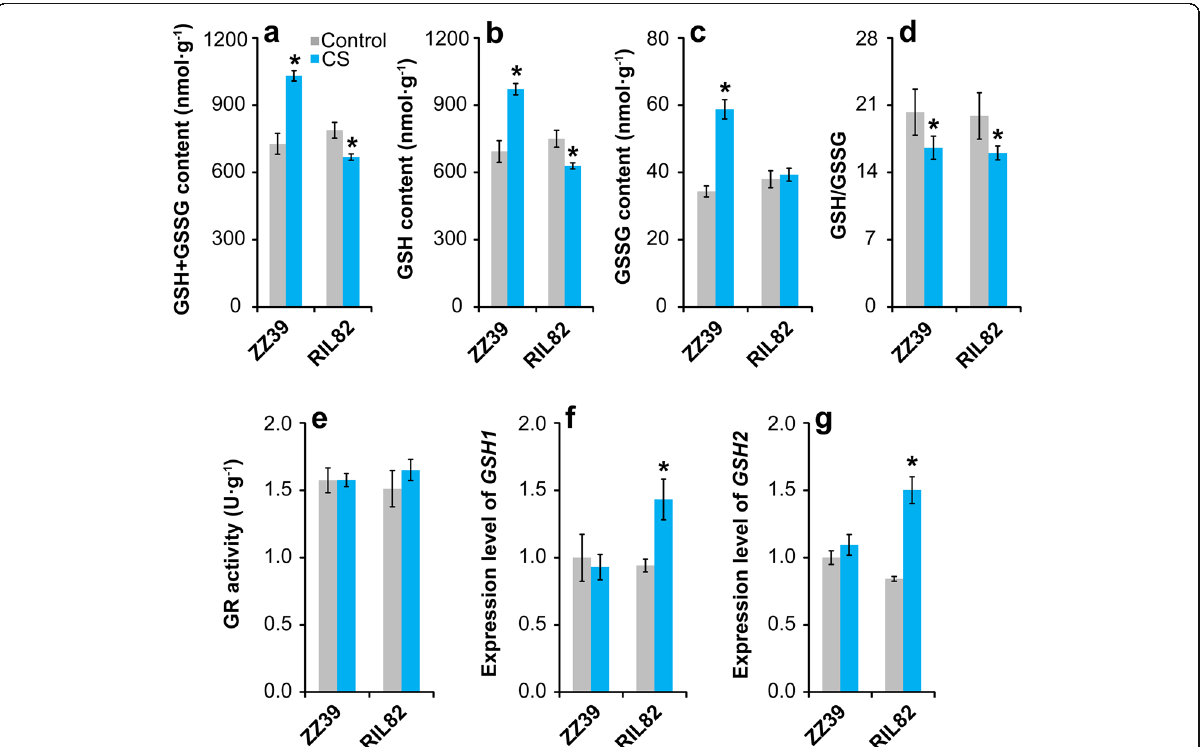
Fig. 3 Effect of cold stress on the GSH metabolism in rice leaves. a , GSH + GSSG; b , GSH; c , GSSG; d , GSSG/GSH; e , GR activity; f , GSH1 ; g , GSH2 . GSH, glutathione; GSSG, glutathione disulphide (Oxidant glutathione); GR, glutathione reductase. Vertical bars denote standard deviations ( n = 4). A t-test was conducted to compare the difference between control and cold stress within a cultivar. * denotes P <